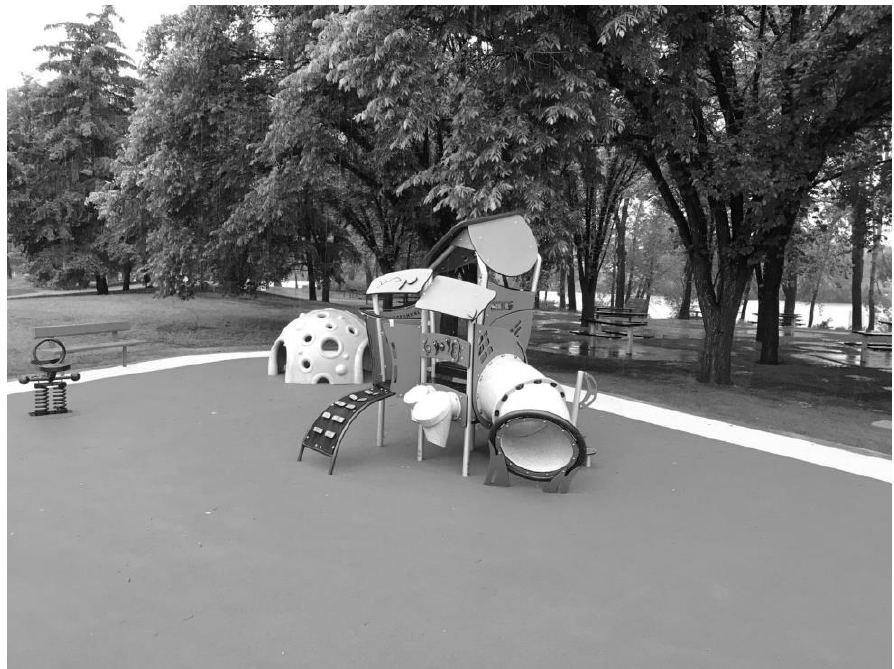
Figure 2. Image depicting part of the early childhood section of the observed playground.